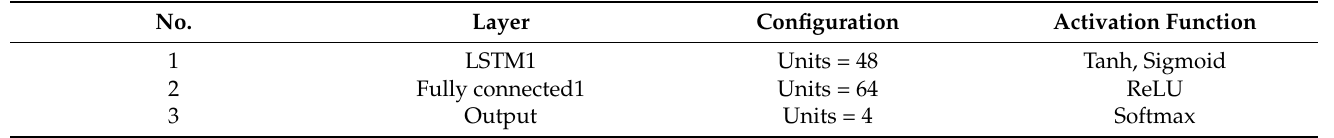
Table A3. Layer configuration of the LSTM model (time step = 3 s, data sets = head +